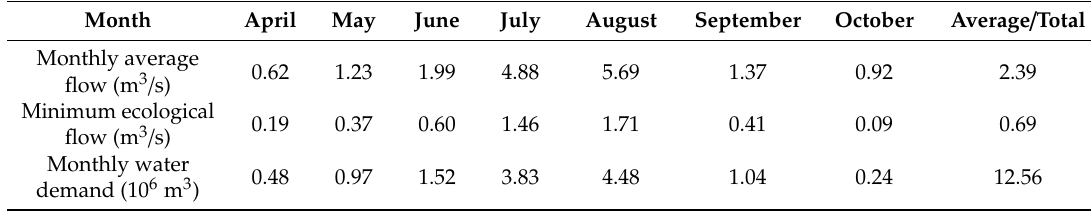
Table 2. Basic flow and water demand of the study area from April to